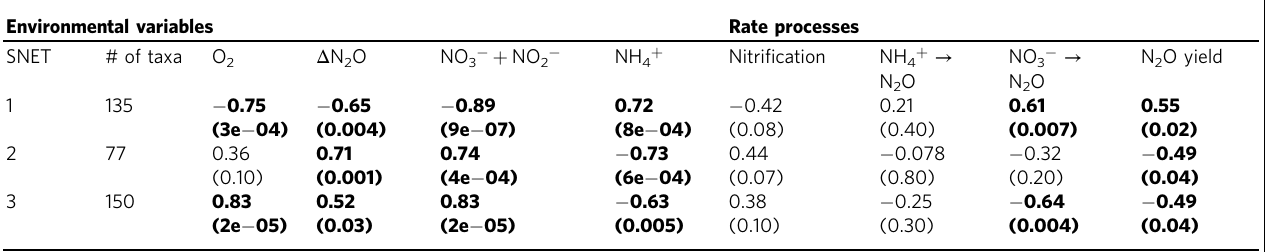
Relationships are reported as Pearson ’ s correlation coef fi cients with corresponding p -values (in parentheses). N 2 O production rates from NH 4 + oxidation and NO 3 − reduction are symbolized by black arrows. Statistically signi fi cant correlations ( p <0.05) are